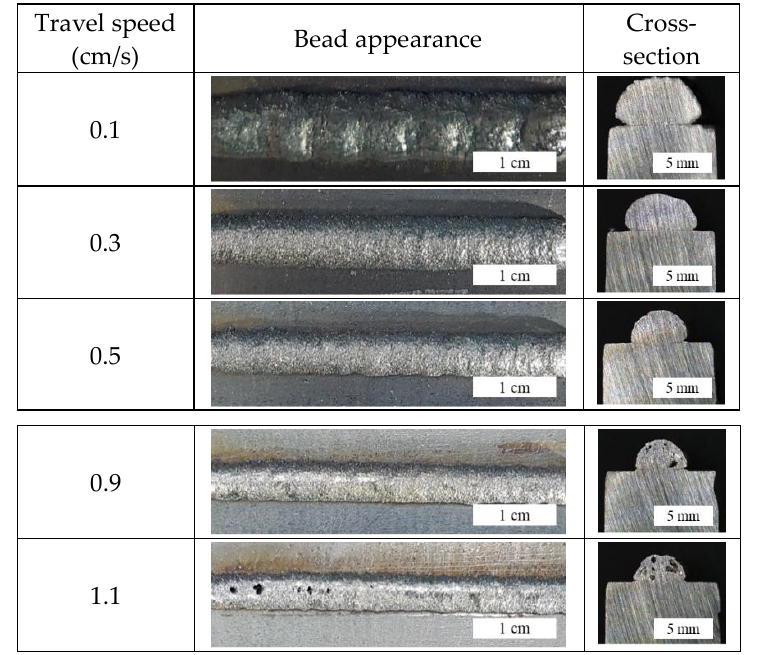
Figure 11. Bead appearance and cross-section of bead with various travel speed.